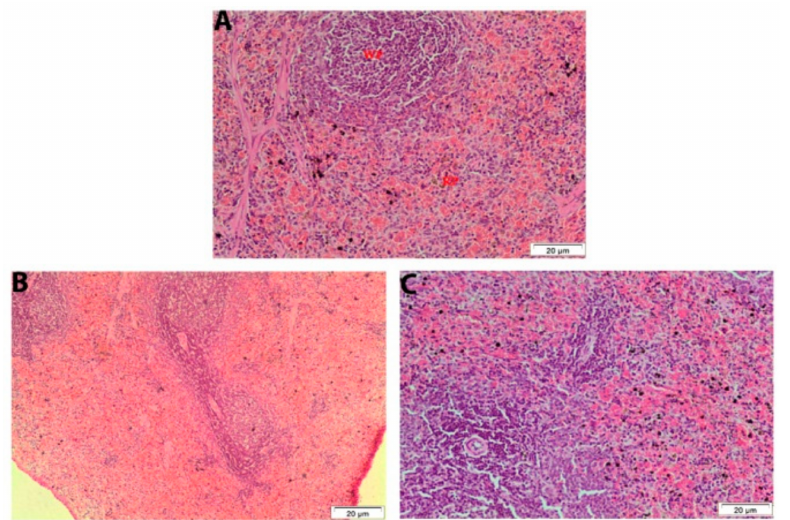
Figure 6. Histological analysis of the spleen tissue in male rat exposed orally to single dose of 250 mg TiSiO 4 NPs/kg b.w. ( A ): Control male rat spleen indicates the darkest region of the white pulp (WP) due to the presence of predominately small lymphocytes. The red pulp (RP) and white pulp are containing lymphocytes. ( B ): Male rat spleen after 7 days post-administration showing degenerated area with highly reduced white pulp. ( C ): Male rat spleen after 28 days post-exposure showing degenerated area disturbed architecture. (H&E stain, Scale bar: 20 µ